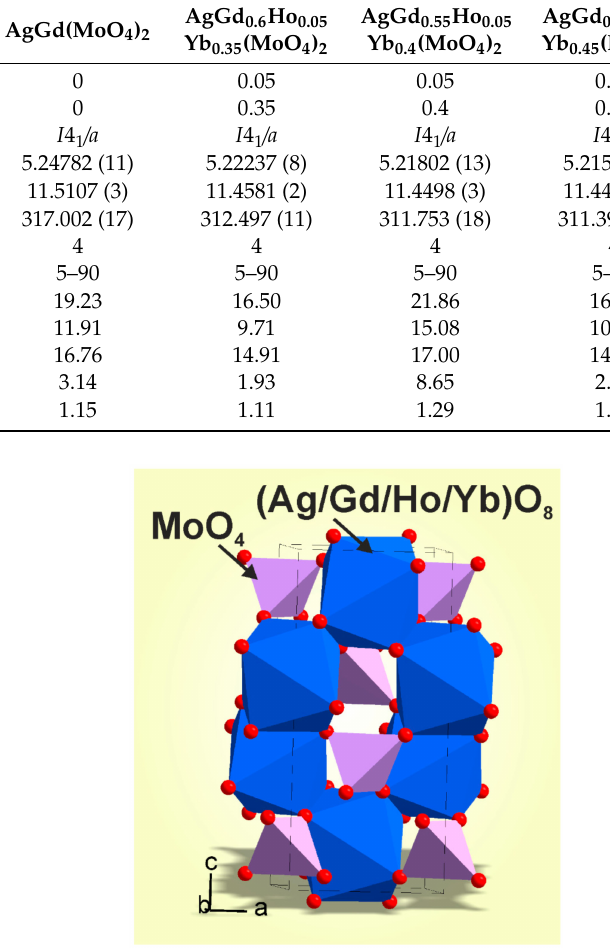
Figure 2. Crystal structure of AgGd 1 − x − y Ho x Yb y (MoO 4 ) 2 . The unit cell is outlined. The lone atoms are omitted for